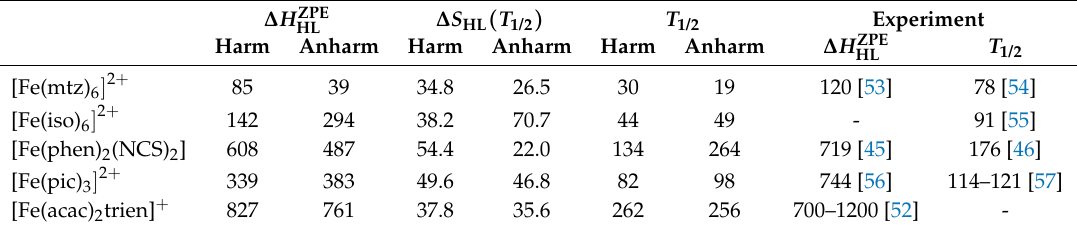
Table 3. Computed values of the zero point corrected HS-LS energy difference, ∆ H ZPE variation at T 1/2 , ∆ S HL ( T 1/2 ) , and transition temperature, T 1/2 . Energies in cm − 1 , temperature in K, and entropy variation in J K − 1 mol − 1